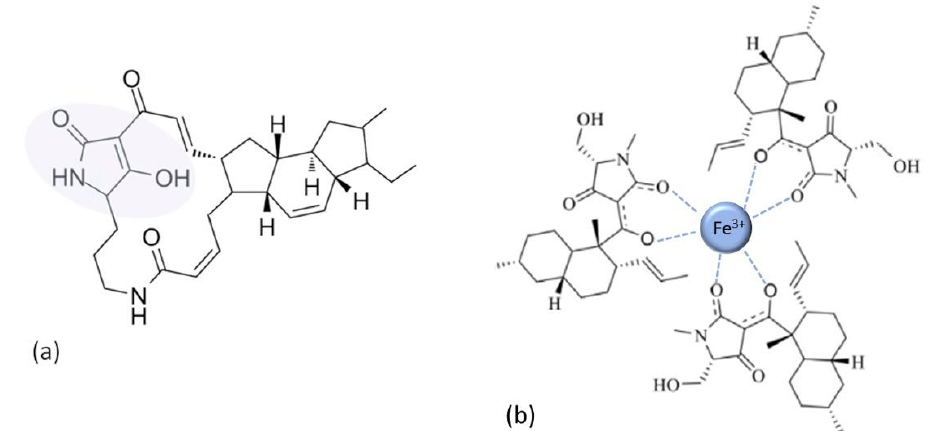
Figure 13. ( a ) Ikarugamycin, a member of the tetramate class and the polycyclic tetramate macrolactams (PTM) subgroup. Tetramate moiety is emphasized in the shaded area. ( b ) An example of the tetramate chelate, comprising three tetramate (equisetin) molecules as bidentate ligands chelating Fe 3+ cation. Inspired by ref. [72].